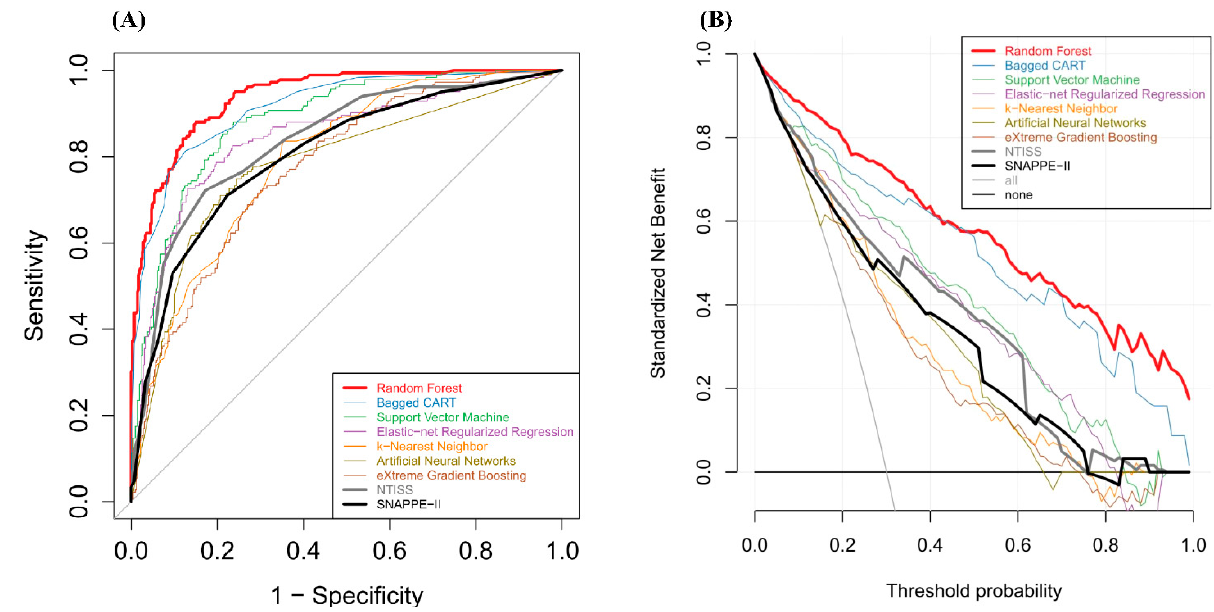
Figure 2. Comparisons of neonatal intensive care unit mortality prediction models such as random forest, NTISS, and SNAPPE-II in the test set. ( A ) Receiver operating characteristic curves of all machine learning models, the NTISS, and the SNAPPE-II. ( B ) Decision curve analysis of all machine learning models, the NTISS, and the SNAPPE-II. Bagged CART: bagged classification and regression tree; NTISS: Neonatal Therapeutic Intervention Scoring System; SNAPPE-II: Score for Neonatal Acute Physiology Perinatal Extension II.